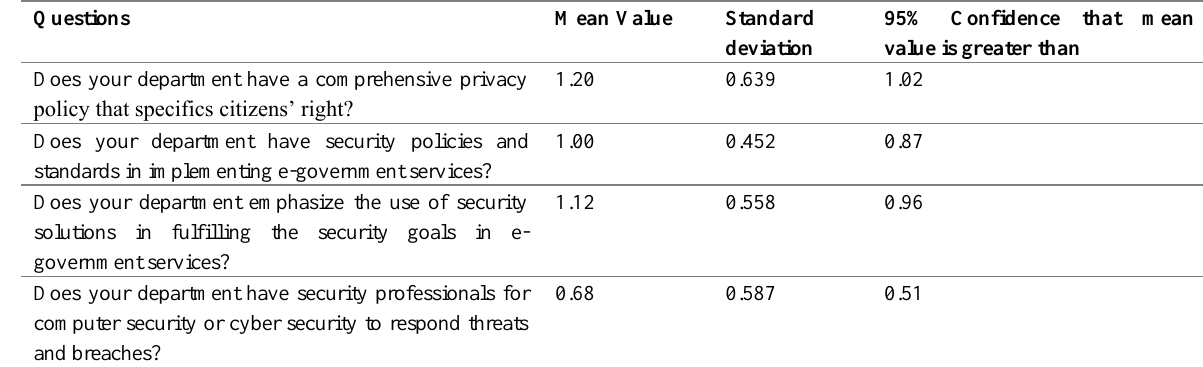
Table 12: Results of Questionnaire Processing Related to Privacy and Security